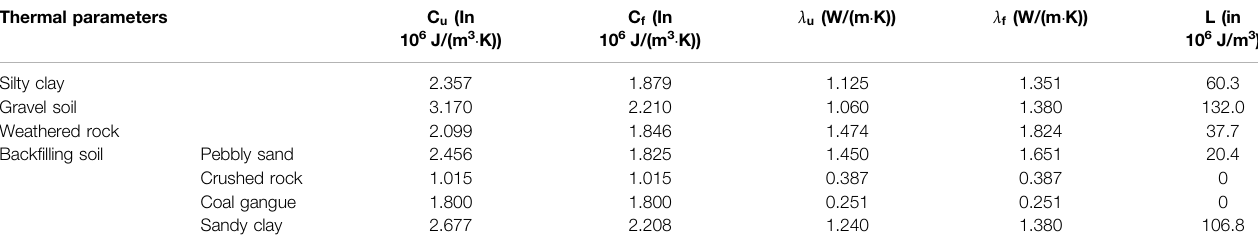
TABLE 2 | Thermal parameters of different media (based on Leng, 2011; Liang et al., 2018; Yang, 2018; Pei et al., 2019; Mu et al., 2020). Thermal